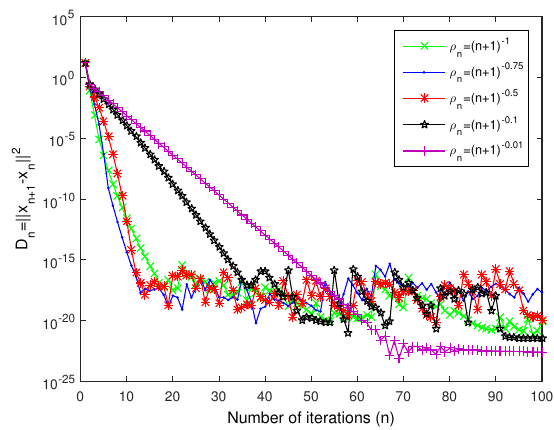
Figure 1. The numerical behavior of D n = || x n +1 − x n || 2 for Algorithm 3 with different choice of ρ n and λ n .